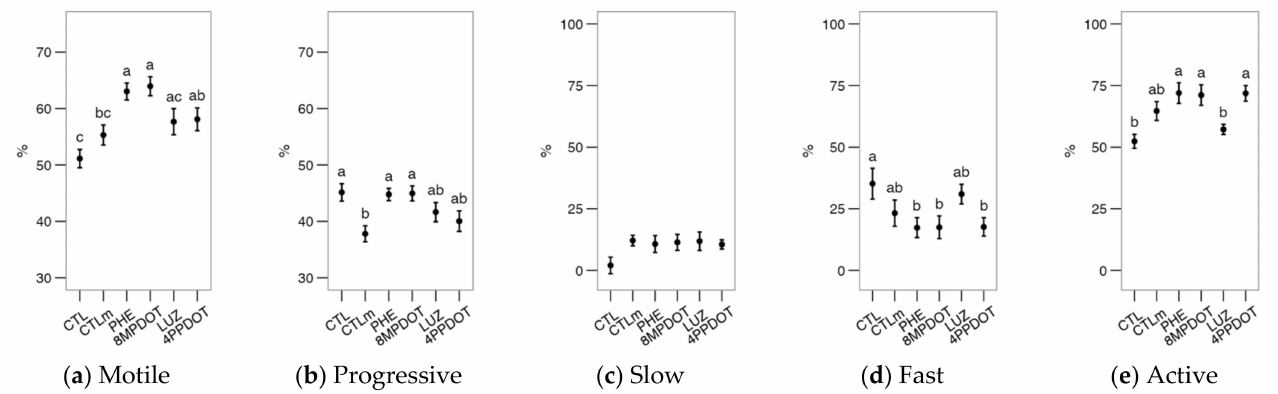
Figure 4. Effects on bull sperm CTC patterns (Ca 2+ distribution from CTC stain) of melatonin receptors agonists (PHE: Phenylmelatonin; 8MPDOT: 8-Methoxy-2-propionamidotetralin) or an- tagonists with 10 nM melatonin (LUZ: Luzindole; 4PPDOT: cis-4-Phenyl-2-propionamidotetralin); CTL: Control; CTLm: Control with 10 nM melatonin. Plots show mean ± SEM for each treatment of seven males. ( a ) % of spermatozoa showing F pattern (non-capacitated spermatozoa showing CTC fluorescence over the head); ( b ) % of spermatozoa showing B pattern (capacitated spermatozoa showing CTC fluorescence on the acrosomal-equatorial region); ( c ) % of spermatozoa showing AR pattern (acrosome-reacted spermatozoa showing CTC fluorescence as a band on the equatorial region). Treatments not sharing the same letters differ significantly ( p < 0.05).